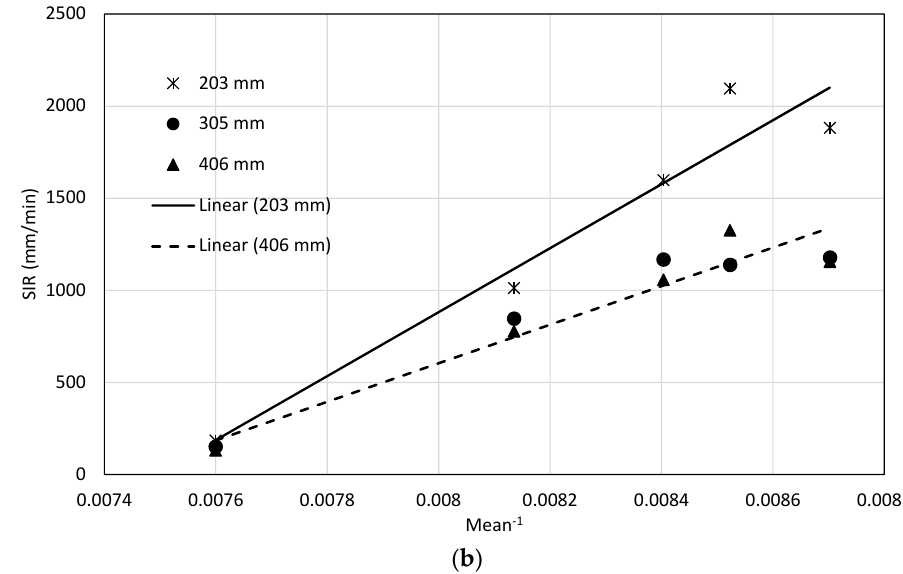
Figure 8. ( a ) Relationship between inverse of the histogram mean image intensity and the measured surface infiltration rate on the Porous Pave surface when the statistic is the mean or the median for the 305 mm ring size using the ASTM standard test; and ( b ) for 203 mm, 305 mm and 406 mm ring sizes. Equation (6) is the expression for the best-fit linear regression line in Figure 8b for the 203 mm ring (using data from Table 2) and Equation 7 corresponds to the 406 mm ring. Equations (8) and (9) are the nonparametric linear